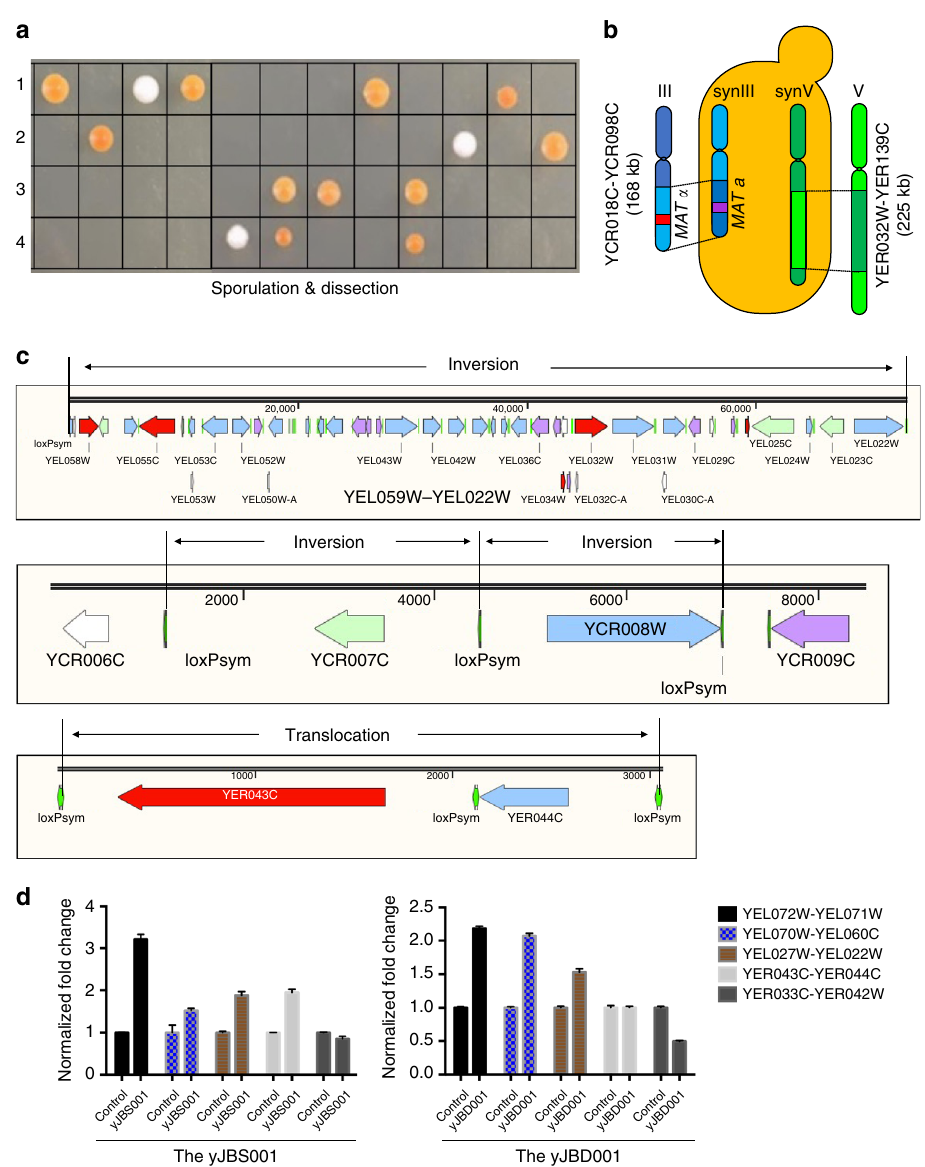
Fig. 4 Sporulation and deep sequencing analysis. a The diploid yJBD001 was sporulated and dissected on permissive agar plates, and the resulting haploid spore clones were analyzed to identify the mating type. b The crossing-over of two larger chromosome fragments was observed in the haploid spore yJBS001. The synIII YCR018C-YCR098C segment (168 kb) was exchanged with the wtIII YCR018C-YCR098C, and the YER032W-YER139C of synV (225 kb) was exchanged with the YER032W-YER139C of V. c Three inversions were observed in the haploid spore yJBS001, including one inversion in synV (YEL059W-YEL022W) and two inversions (YCR007C and YCR008W) in synIII. A translocation of YER043C-YER044C was observed in synV. d The copy numbers (duplication and deletion) of fi ve locations in the diploid yeast yJBD001 and its spore yJBS001 were veri fi ed by qPCR. Error bars represent SD from three independent